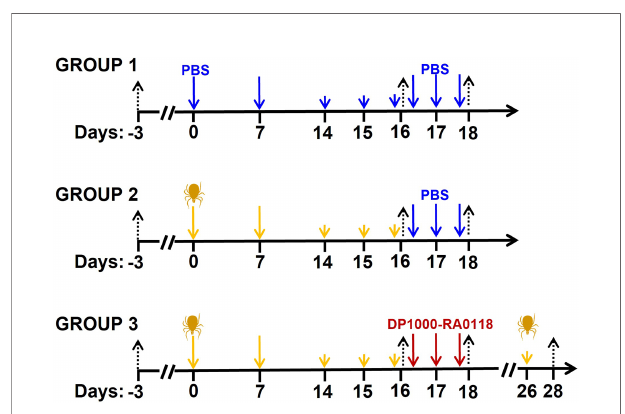
FIGURE 3 | Scheme of GalT-KO mice sensitization for anti- a Gal IgE production. Group 1: double negative control (PBS) (n=16). Group 2 (n=16) and Group 3 (n=16) ( a Gal-sensitized mice) were treated with PBS (control) and DP1000-RA0118, respectively. Black arrows: bleeding (for immunological determinations), blue arrows: PBS id. (control of sensitization) or sc. (control of treatment), yellow arrows: salivary gland extract (20 or 5 µg id.), dark-red arrows: DP1000-RA0118 10 mg/kg